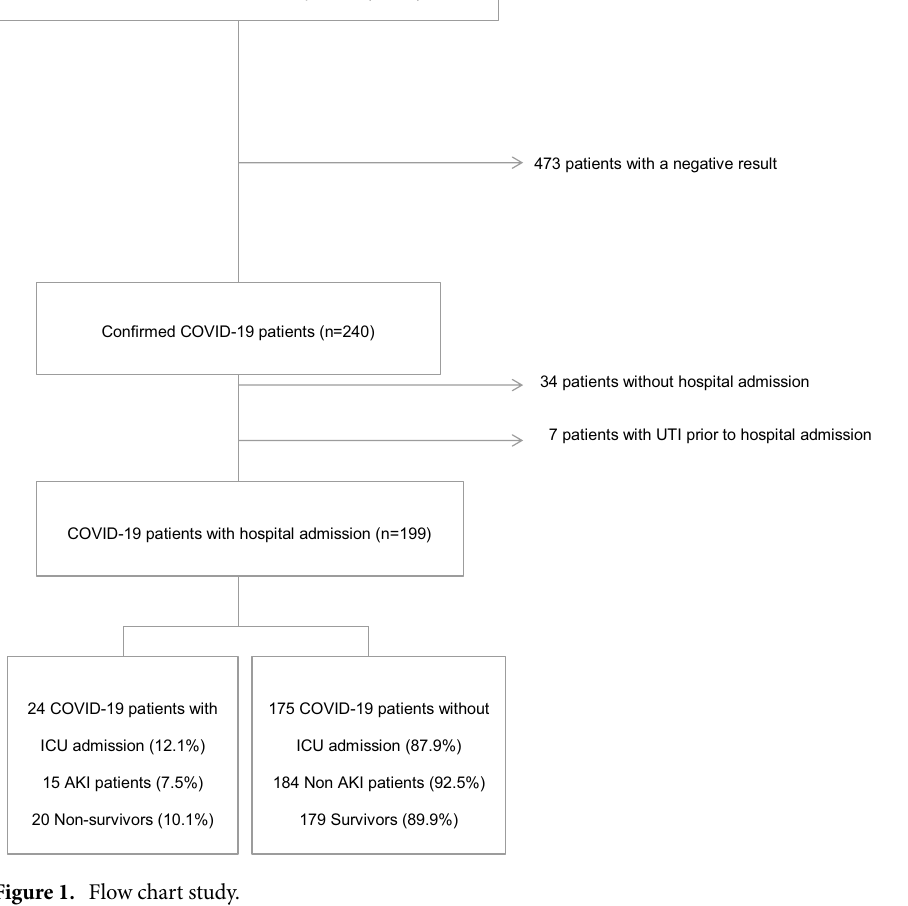
Figure 1. Flow chart